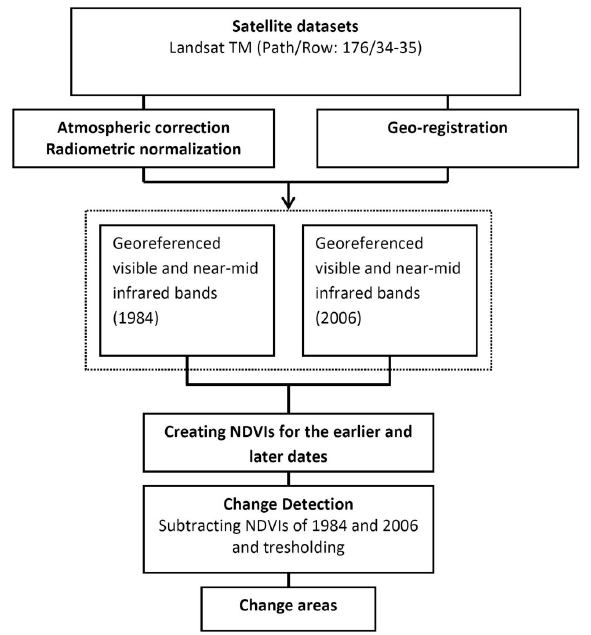
Fig. 3. Flow of the change detection